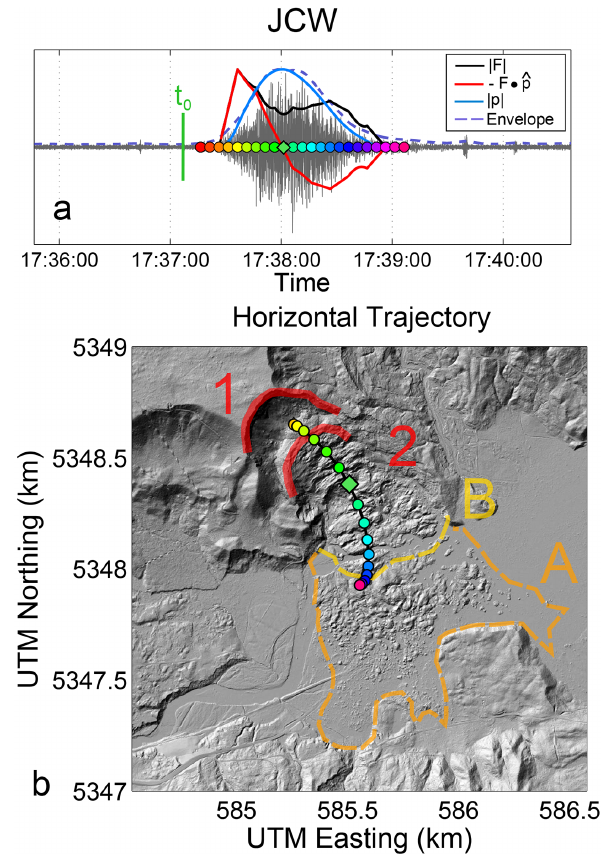
Figure 5. (a) Short-period seismogram at station JCW filtered be- tween 3 and 10Hz together with the modulus of the inverted forces (black curve), the scalar product of the opposing force F and the normalized momentum b p (red curve), the modulus of the inverted momentum (blue curve) and the smoothed envelope. Time t 0 in- dicates the origin start time of the LFH, before shifting it by the travel time of the seismic waves. (b) Inferred centre-of-mass trajec- tory for the first landslide. Coloured dots indicates the time at which the centre of mass occupied the corresponding position along the in- ferred trajectory. The yellow and orange-dashed contours labelled A and B indicate the extent of the first and second landslides deposits respectively, identified by Keaton et al. (2014). The red lines la- belled 1 and 2 indicate two possible locations for the source area of the second